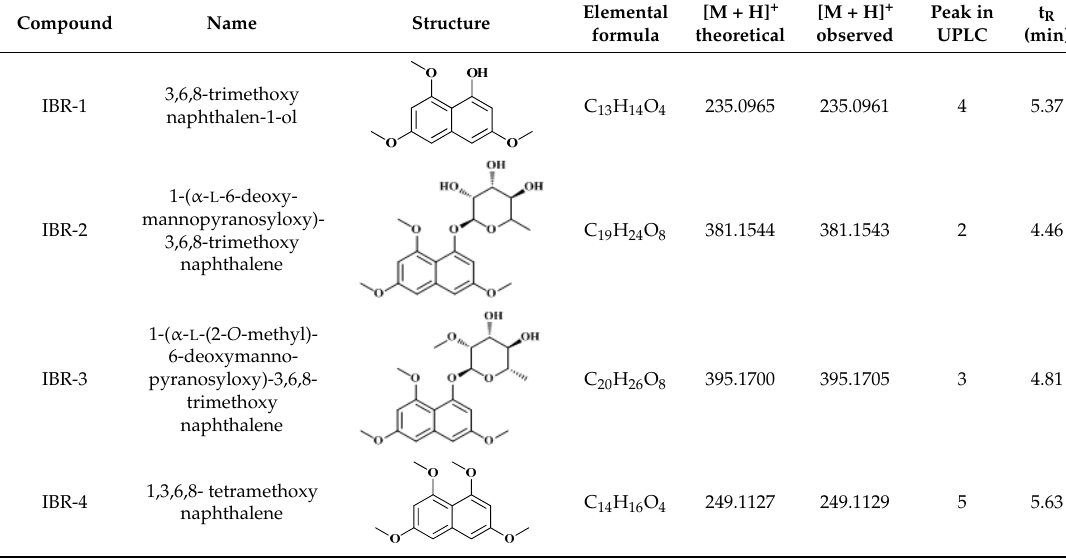
Elemental [M + H] + formula